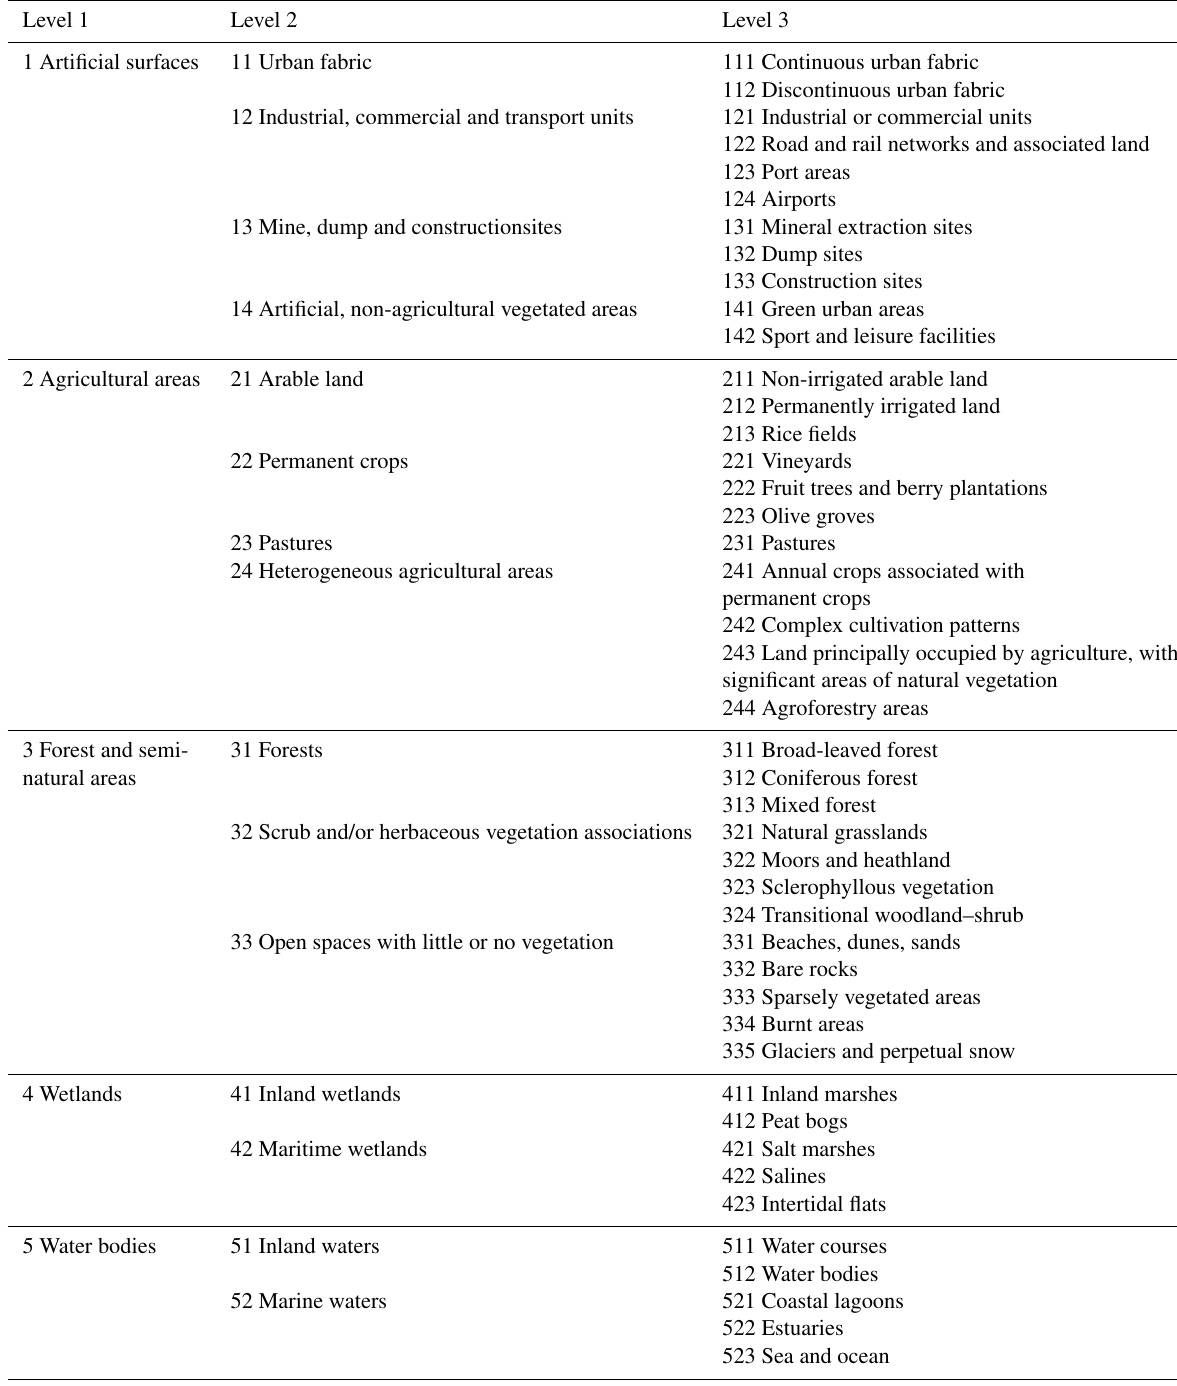
Table 1. CORINE Land Cover (CLC) nomenclature. Numbers on the left represent the CLC code (source: EEA,